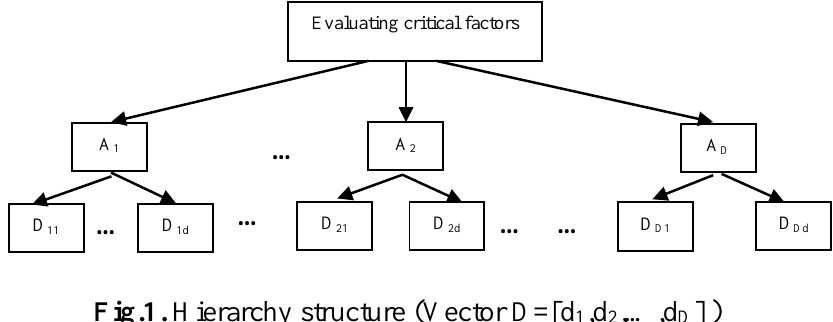
Fig.1. Hierarchy structure (Vector D=[d 1 ,d 2 ,…,d D ]